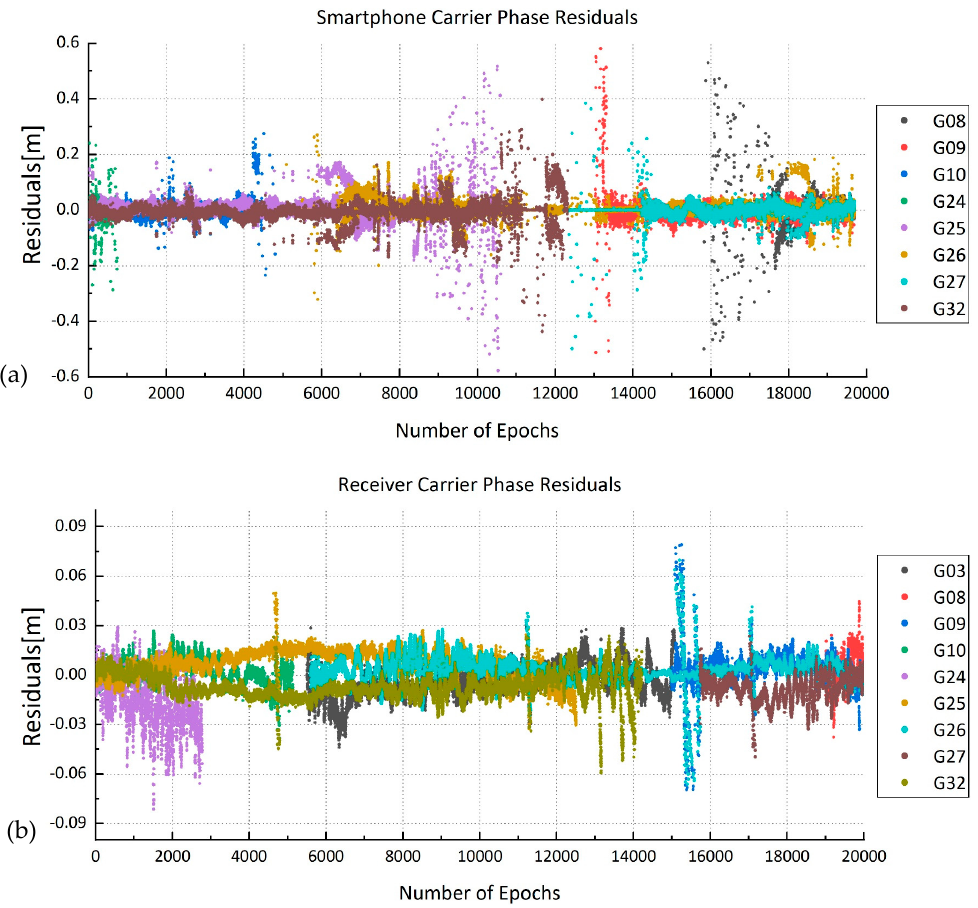
Figure 6. Carrier phase residuals of smartphone and receiver in static mode (( a ) smartphone; ( b ) receiver). Table 5. Standard deviation of carrier phase residuals of smartphone and receiver (m).